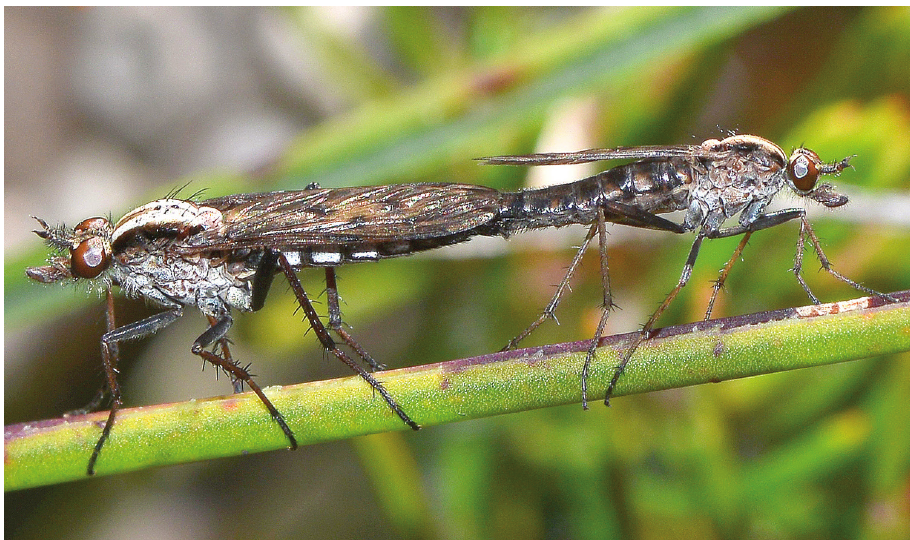
Figure 2. Sidarena hortorum sp. n. mating pair; Bullsbrook Nature Reserve, Bullsbrook, Western Australia. (Photo credit: Fred and Jean Hort).